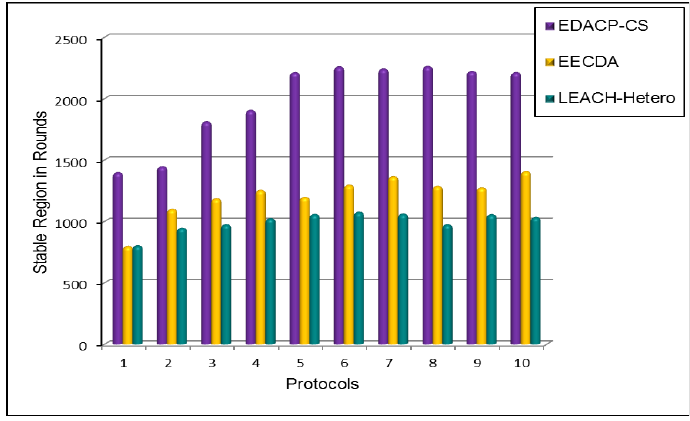
Figure 11. Network stability in EDACP-CS,EECDA, and LEACH-Hetero.